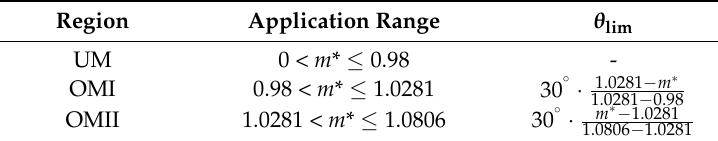
Table 2. Limiting reference vector angle θ lim for overmodulation region.